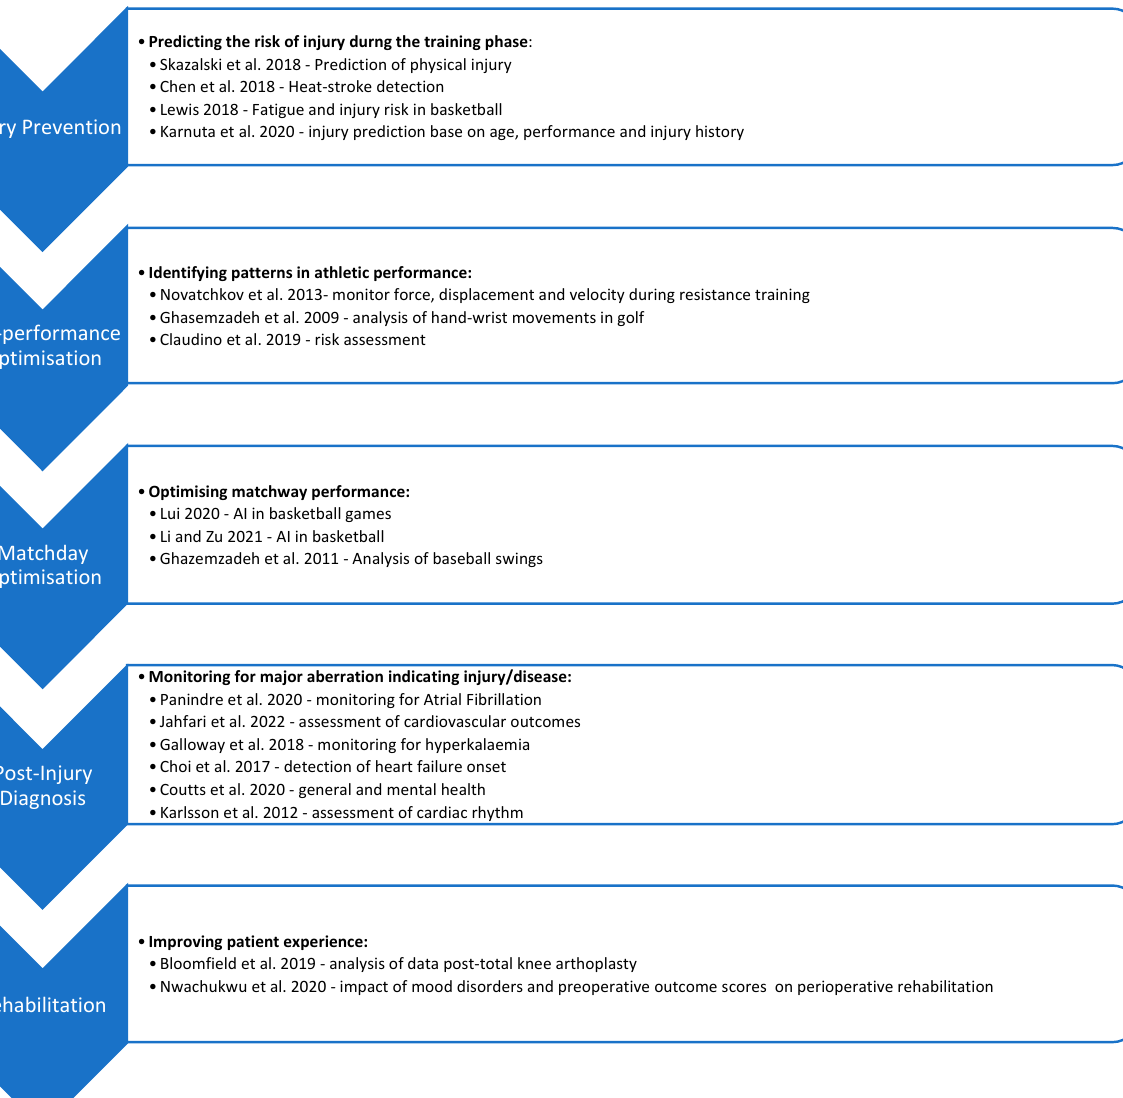
Figure 2. Classification of studies reporting sensors’ use in the different phases of sports [9–26].